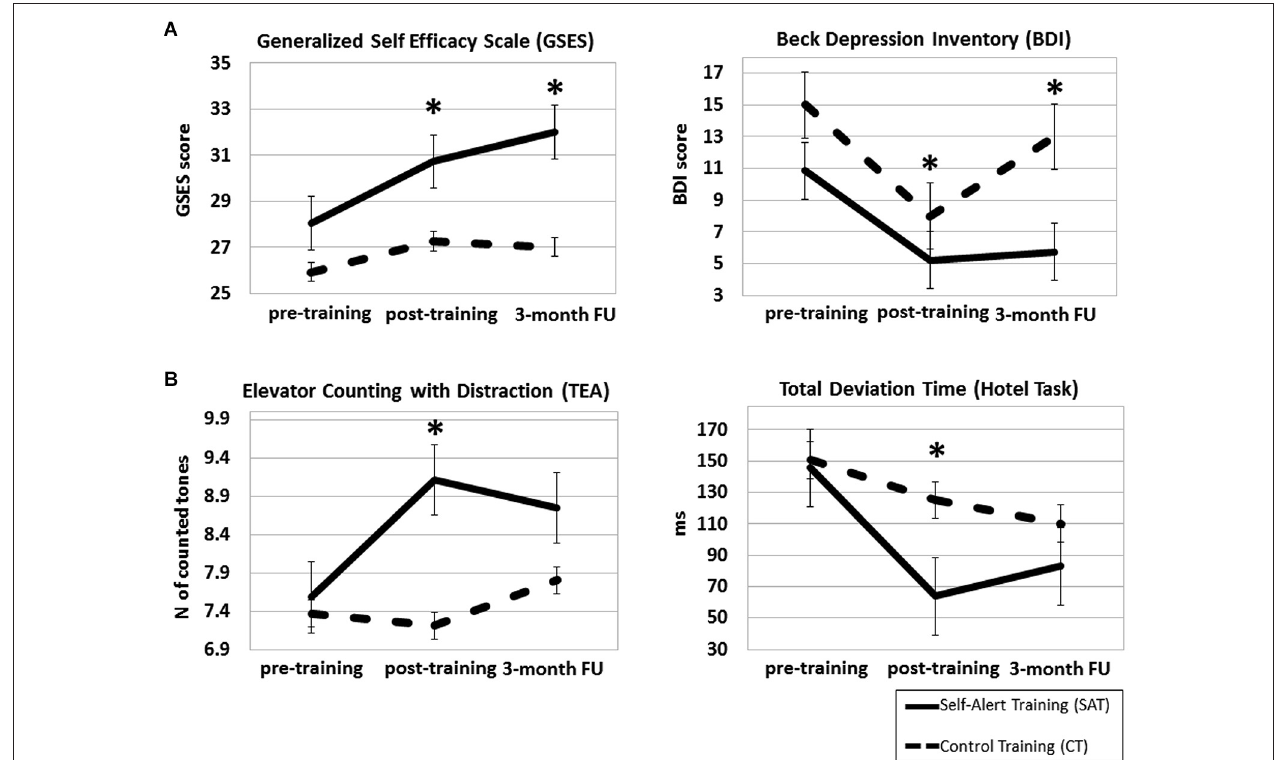
the 3-month follow up . The SAT group showed increased significantly self-efficacy scores, decreased depressive symptoms at both assessments and improved scores in both cognitive tasks after training. Error bars represent standard errors. ∗ Indicates statistically significant